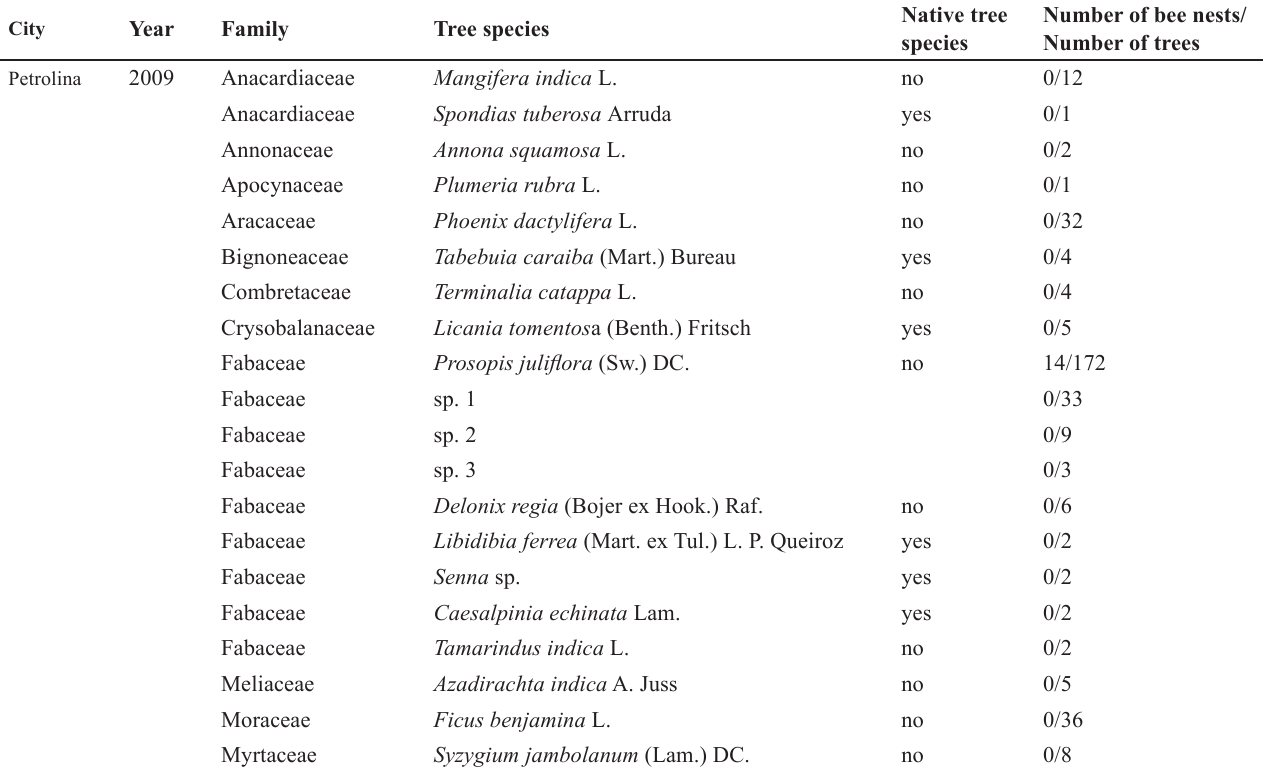
Table 1 . Trees investigated for Plebeia aff. flavocincta nests in Petrolina and Juazeiro, in 2009, 2015 and